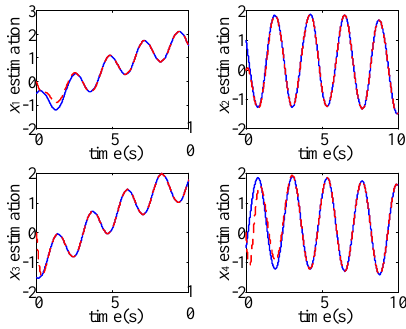
Figure 1. State observation by sliding mode observer (SMO).